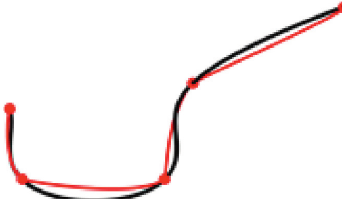
Figure 7: Cubic spline fitted for 1st iteration of GA.